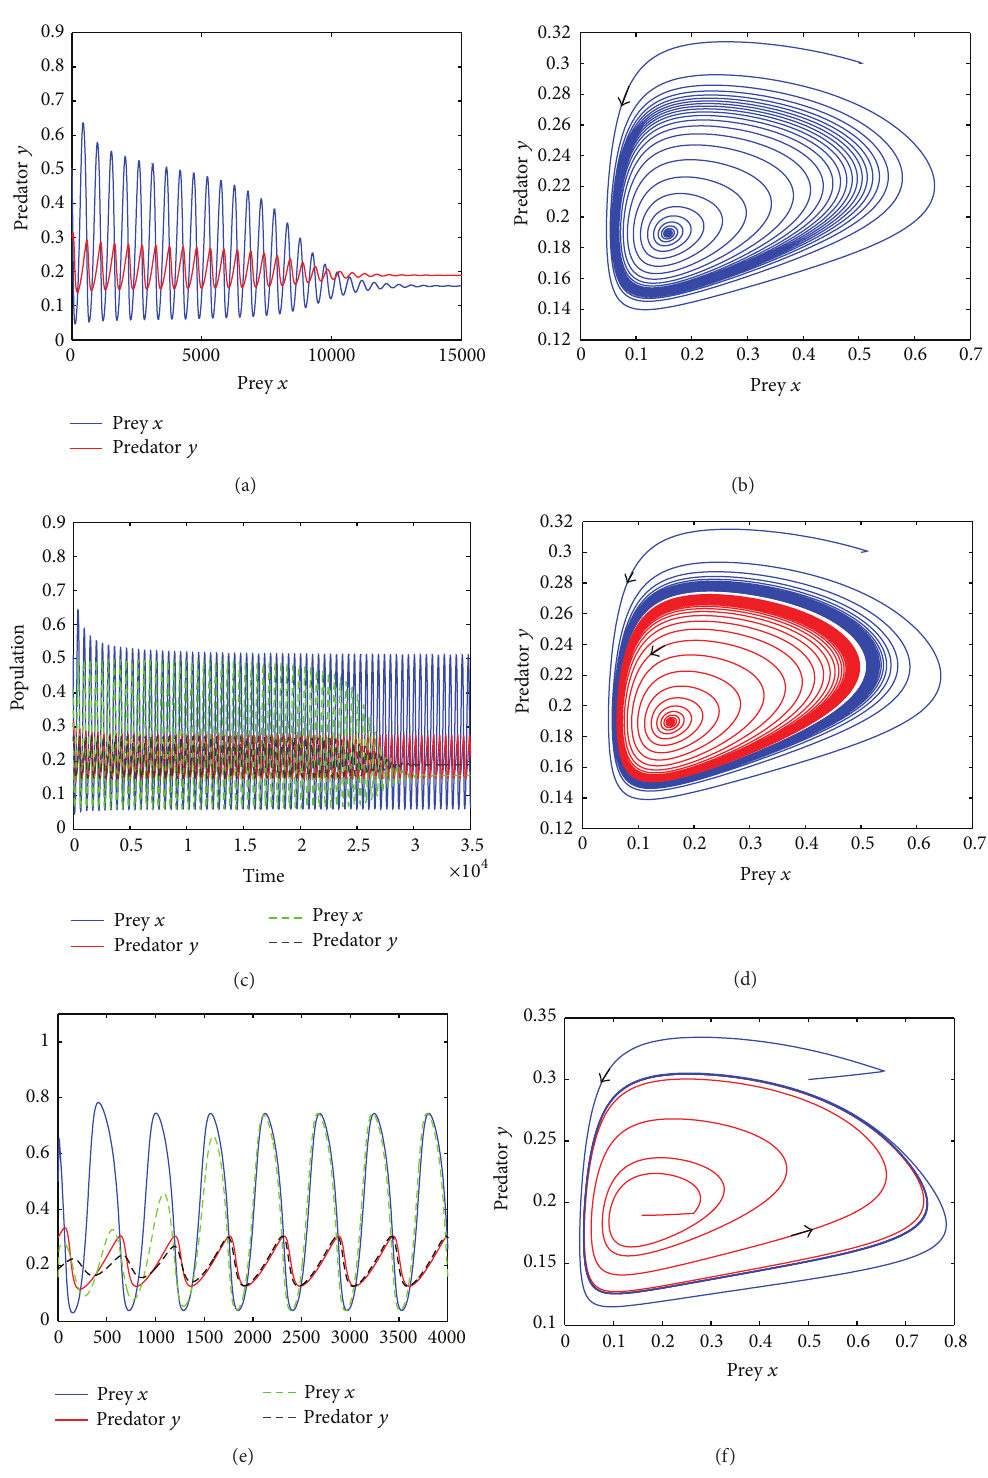
Figure 7: The trajectory graphs and phase portrait of system (6) for (𝛼,𝛽) ∈ 𝐷 2 with 𝛼 = 0.2 , 𝛽 = 1.2 , and 𝛾 = 0.06 . (a)-(b) For 𝜏 = 0.04 < 𝜏 0 , the positive equilibrium 𝐸 ∗ is stable. The initial values are (0.5, 0.3) . (c)-(d) For 𝜏 = 0.05 < 𝜏 0 , the positive equilibrium 𝐸 ∗ is stable with an unstable periodic orbit. The initial values are (0.4, 0.258) and (0.5, 0.3) . (e)-(f) For 𝜏 = 0.65 > 𝜏 0 , the positive equilibrium 𝐸 ∗ is unstable with an stable periodic orbit. The initial values are (0.1578, 0.18935) and (0.5,0.3)